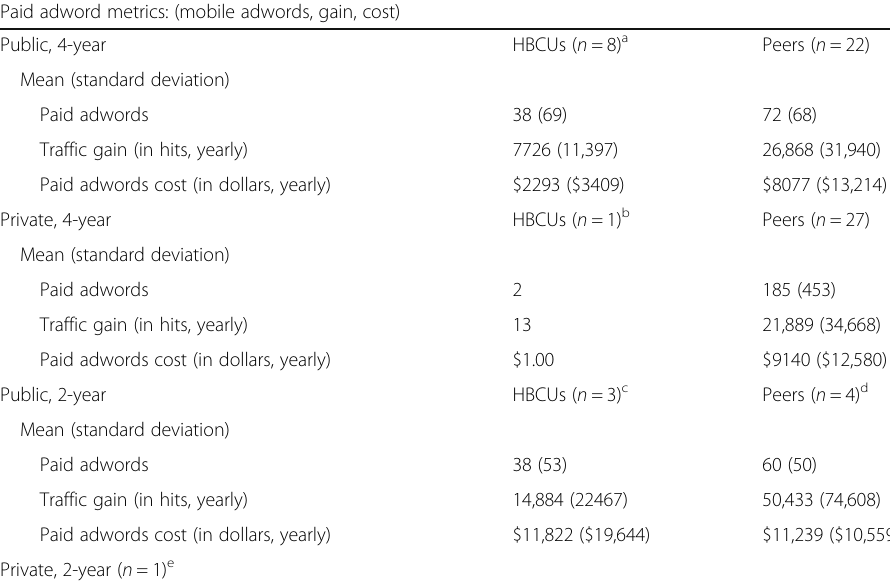
Table 3 Comparison of HBCUs to comparable institutions by mobile paid adwords, current as